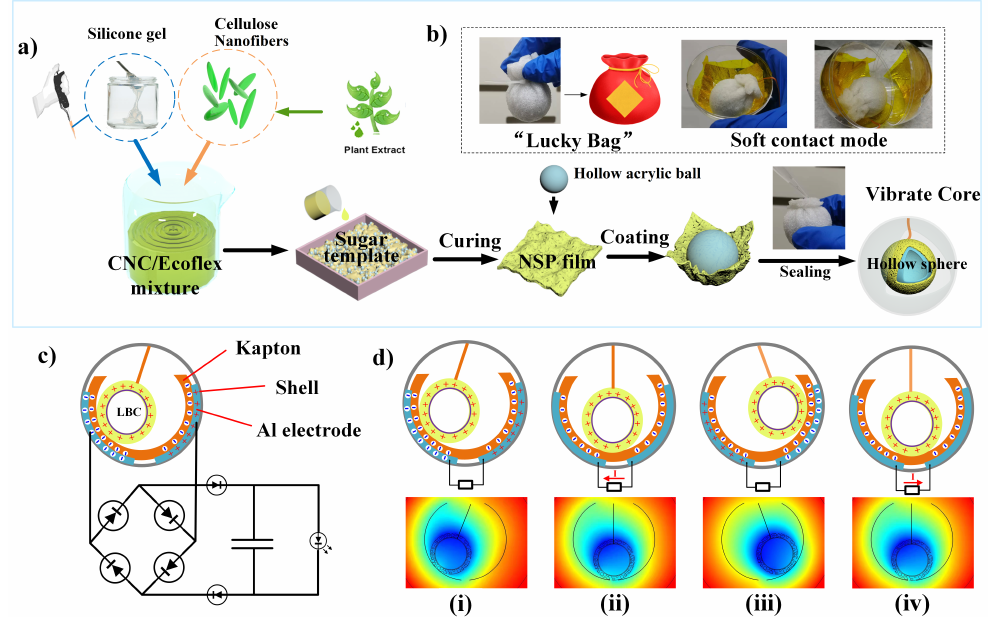
Figure 1. ( a ) Schematic illustration for the synthesis of the NSP film and assembly of the rolling vibrator; ( b – d ) Corresponding digital photographs of the L-ball and NS-TENG. ( c ) Circuit diagram of the self-powered system consisting of a TENG and a capacitor. ( d ) Charge distribution scheme of the device under the short-circuit condition and the corresponding simulated potential distributions under the open-circuit